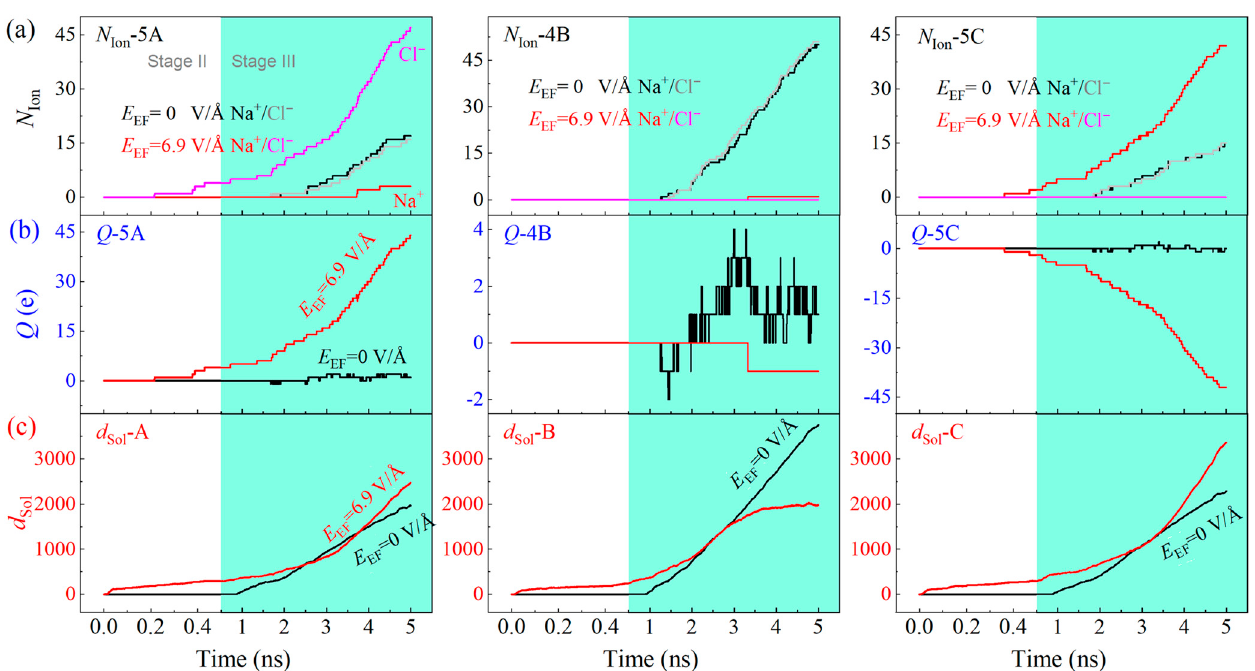
Figure 3. Physical quantities of the solution with C NaCl = 0.6 mol/L flowing through the A-30 CTT nanochannel in the system with or without the electric field with the intensity ( E EF ) of 6.9 V/Å. ( a ) The number of ions in the three containers, ( b ) the electric charges in the three containers, and ( c ) the discharge of solution via the three subchannels in each CTT.